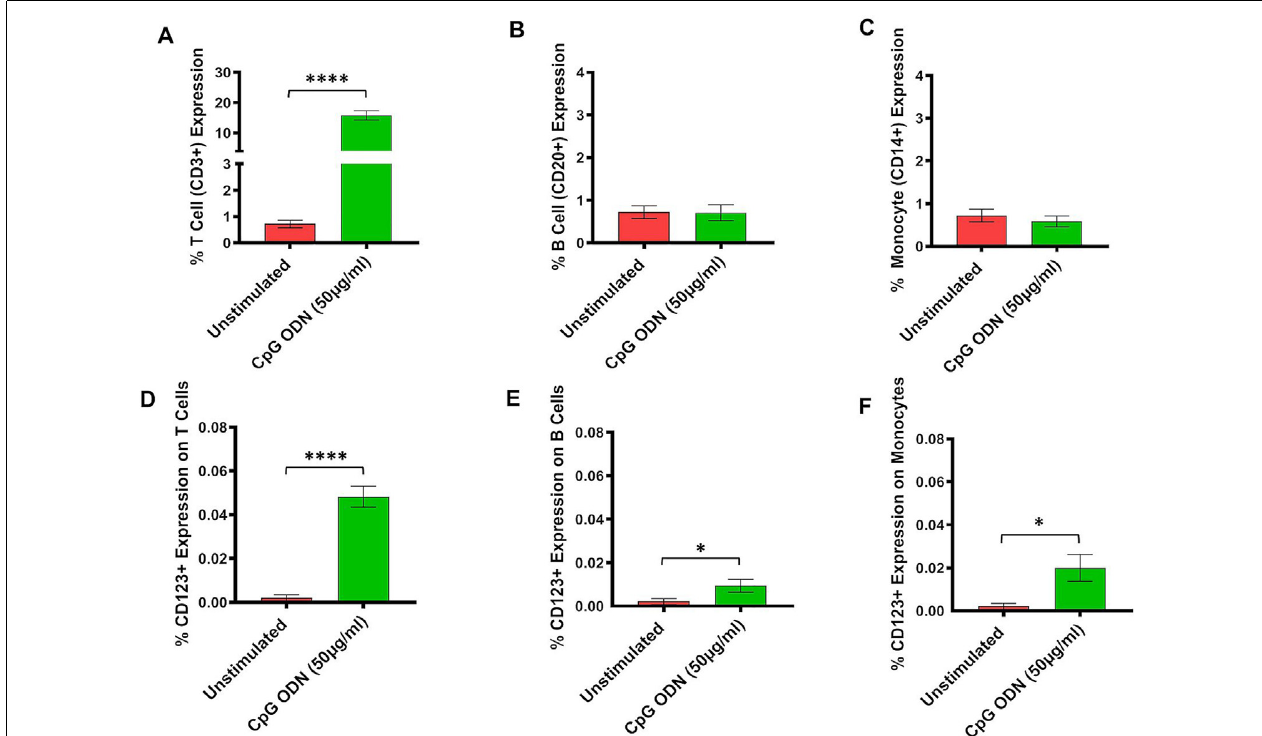
FIGURE 4 | (A–F) Analysis of lymphocytes and monocytes expression in CpG ODN stimulated SQM PBMCs. PBMCs were isolated from the whole blood and aliquots of PBMCs were stimulated with 50 µ g/ml CpG ODN for 30 h at 37 ◦ C. PBMCs were stained with antibodies to T cells (CD3+; A) , B cells (CD20+; B) , and monocytes (CD14+CD16 − ; C) . Values on the Y-axis (A–C) are % expression of lymphocytes and monocytes. Similarly, to identify CD123 expression on T cells (CD3+; D ), B cells (CD20+; E ), and monocytes (CD14+; F ) PBMCs were stained with CD123. The samples were acquired on a FACS Celesta TM flow cytometer using DIVA software (BD) and analyzed using FlowJo (Tri Star, CA, USA). Values on the Y-axis (D–F) are % expressions of CD123 marker on lymphocyte and monocyte cell populations. Symbols representing significance are: ∗∗∗∗ p < 0.0001; ∗ p <